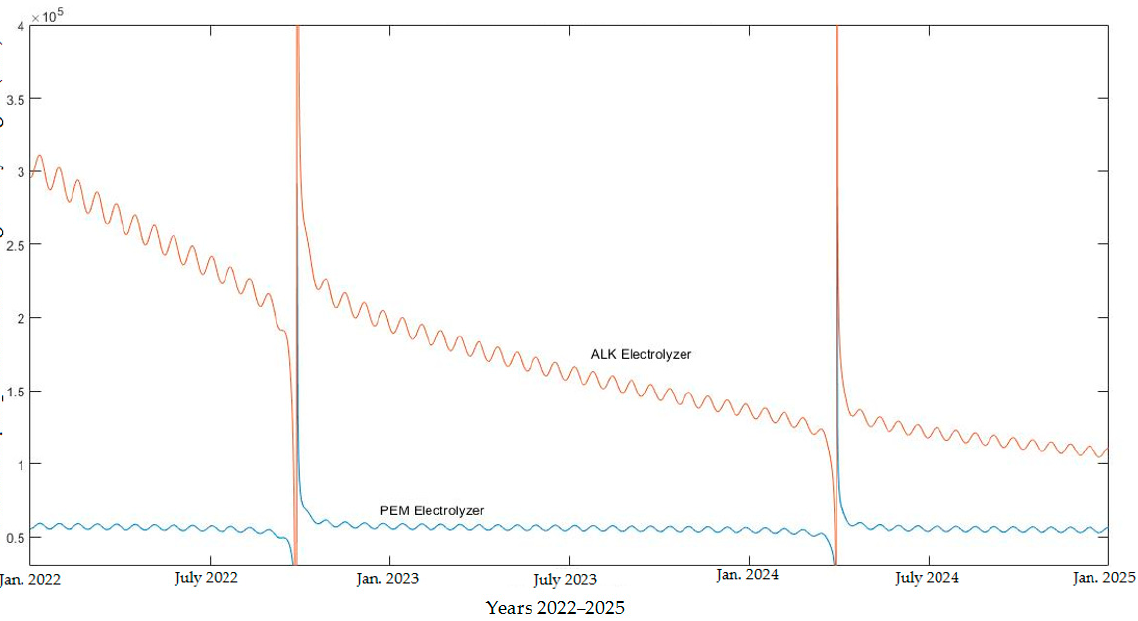
Figure 8. PV a rea required to produce 1 kg/s of hydrogen during 2022–2025, ALK versus PEM. Figure 8. PV area required to produce 1 kg/s of hydrogen during 2022–2025, ALK versus